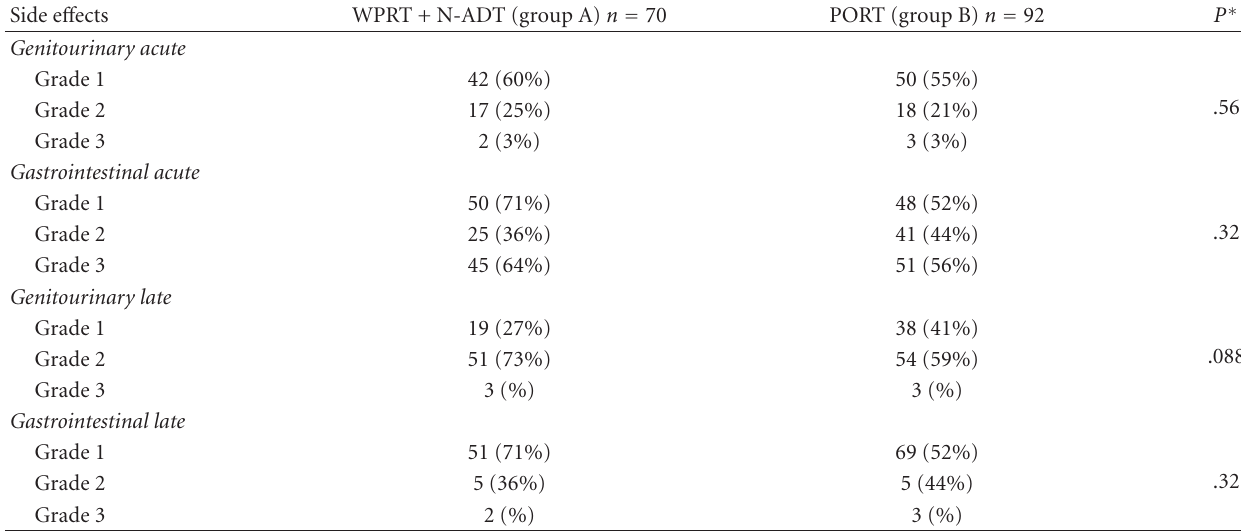
Table 2: Acute and late gastrointestinal and genitourinary side e ff ects reported in study for high-risk patients ( n = 162). Side e ff ects